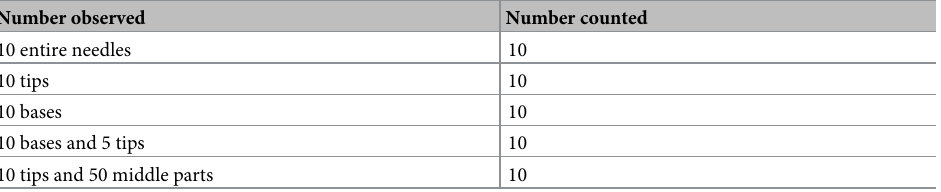
Table 1. Counting method applied to conifer needles. Table from Heiss [173],